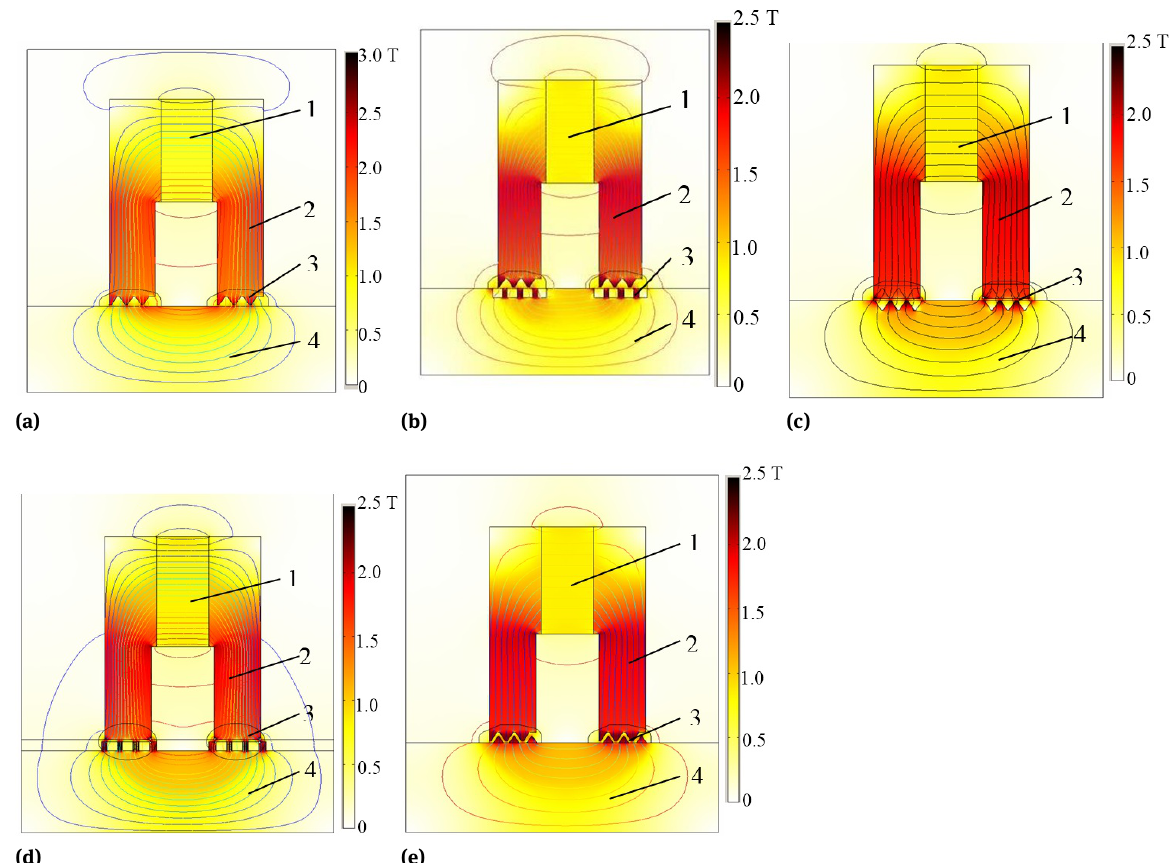
Figure 1: The distribution of the module of the magnetic induction vector (in color) and the force lines of the vector magnetic potential for: a) – the sealer of classical design; b) – with teeth on the magnetic circuit of trapezoid form and “inner” teeth of rectangular form on the shaft; c) – with “inner” teeth of trapezoid form on the shaft; d) – with “inner” teeth of cylindrical form on the shaft; e) – with the teeth of trapezoid form on the magnetic circuit and “outer” teeth on the shaft.